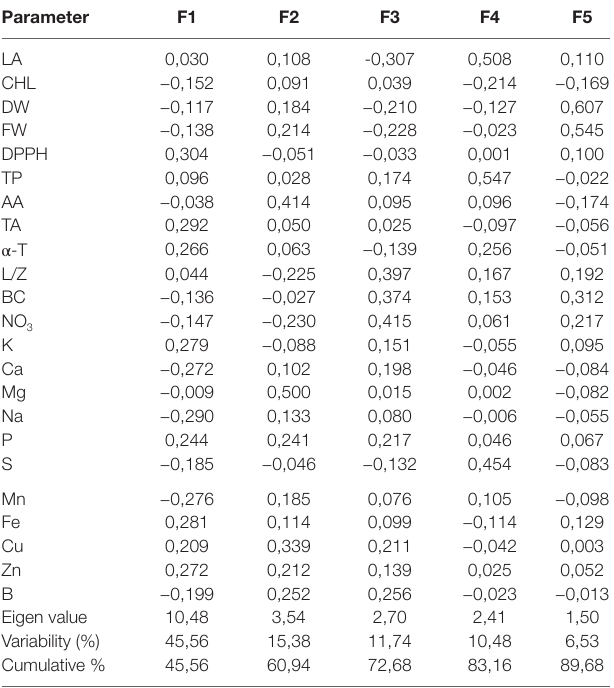
TABLE 4 | Eigenvalue, factor scores, and contribution of the first five principal component axes to variation in mustard microgreens under supplemental UV-A LED radiation.